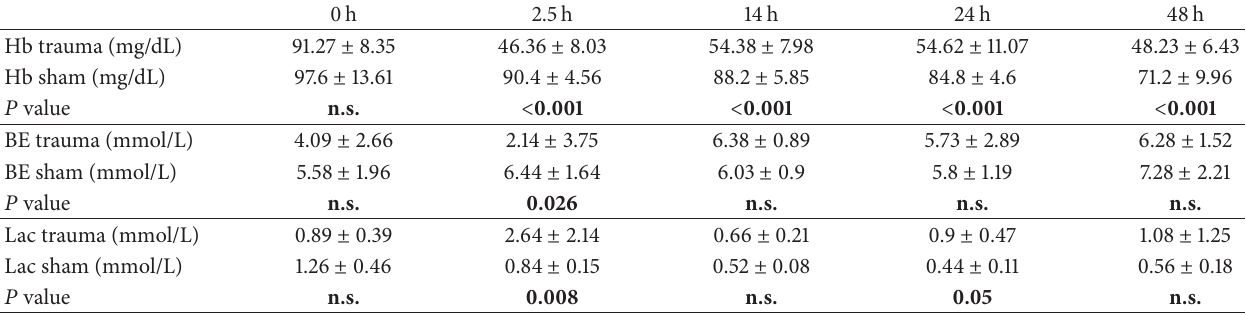
Table 1: Laboratory parameters: hemoglobin (Hb), base excess (BE), lactate (Lac), and not significant (n.s.).